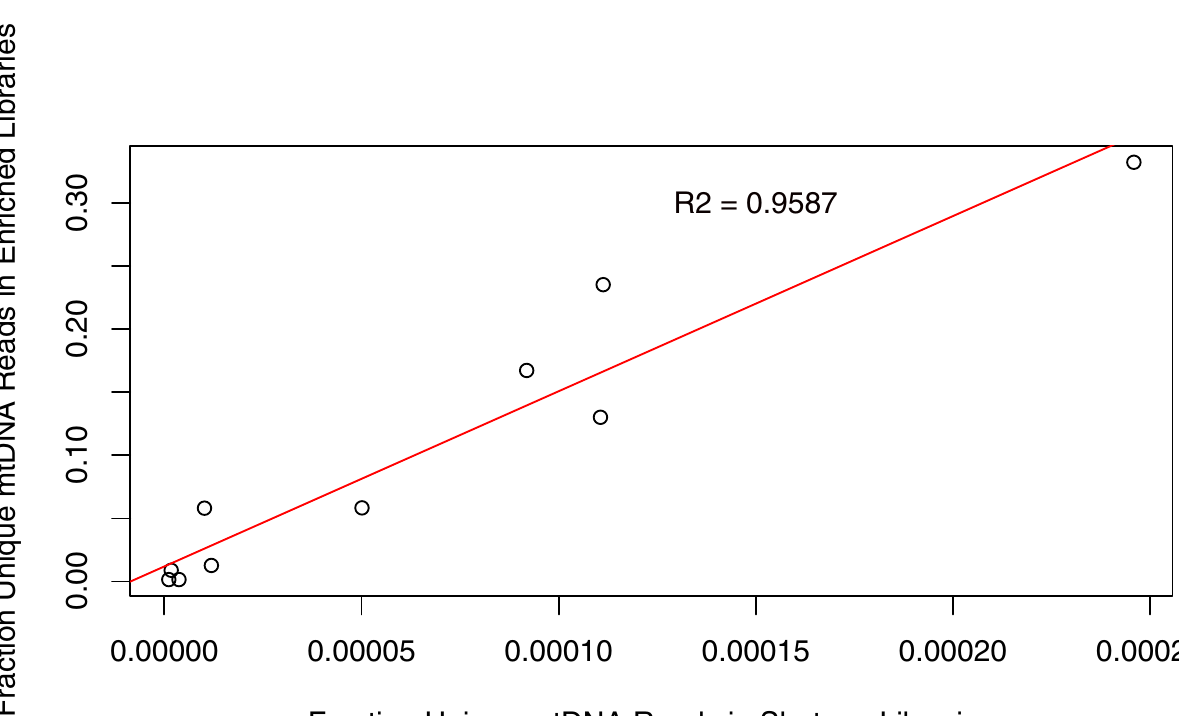
Fig 3. Correlation of fraction unique mapped reads in wombat libraries. The fraction of unique mapped reads for the wombat shotgun and mtDNA enriched libraries was generated by dividing the number of unique mapped reads by the number of collapsed reads (Table 4). The high correlation between the fraction of unique reads in shotgun and enriched libraries suggest that initial screening of a sample with shallow sequencing and adjusting sequencing effort accordingly may reduce the cost of studies involving hybridization capture enrichment.